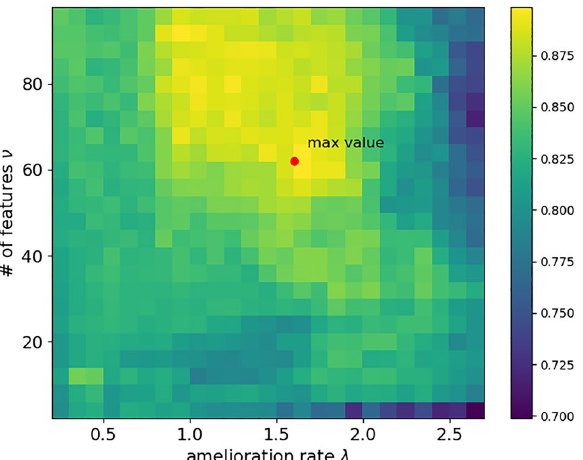
Figure 4. Grid search results for the choice of hyperparameters. A heatmap of binary classification accuracy with respect to the hyperparameters λ and ν for a single representative patient. The set of parameters λ = 1.6 and ν = 62 yielded to the optimal accuracy for this patient.